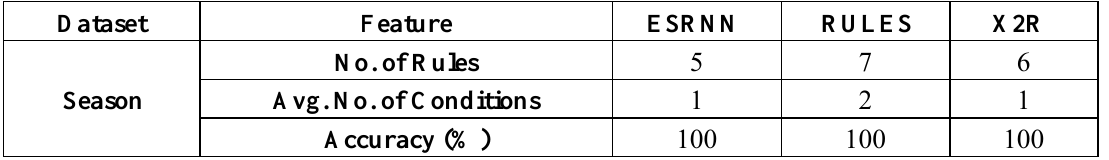
Table 13. Performance comparison of ESRNN with other algorithms for season data.